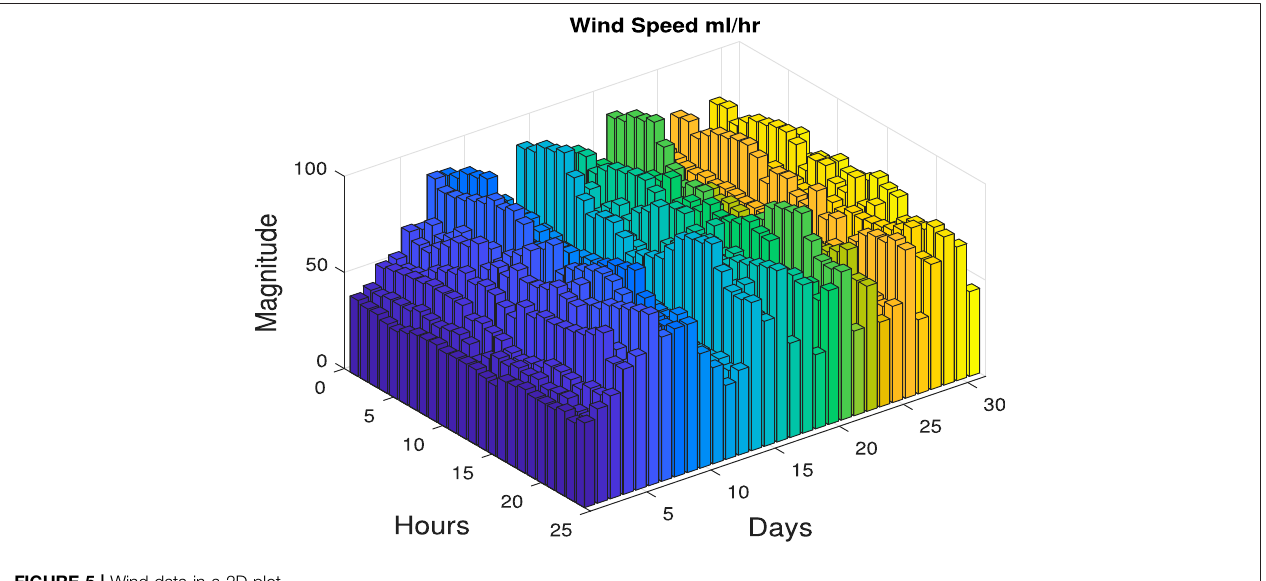
FIGURE 5 | Wind data in a 2D